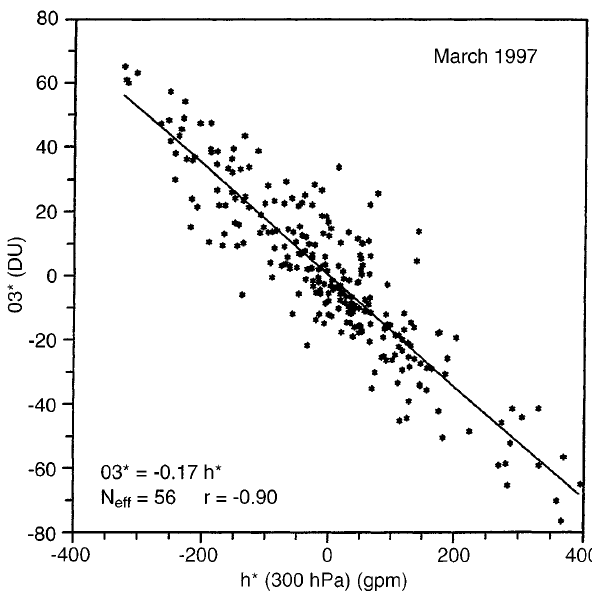
Table 1. Statistical parameters of the relation of zonally asymmetric ozone and geopotential